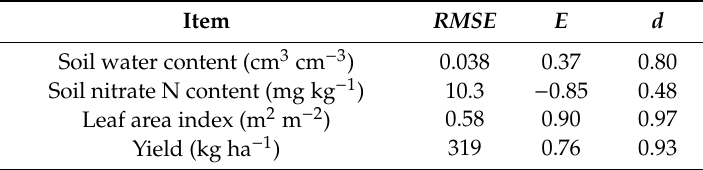
Table A5. Evaluation of the model’s simulation e ff ects